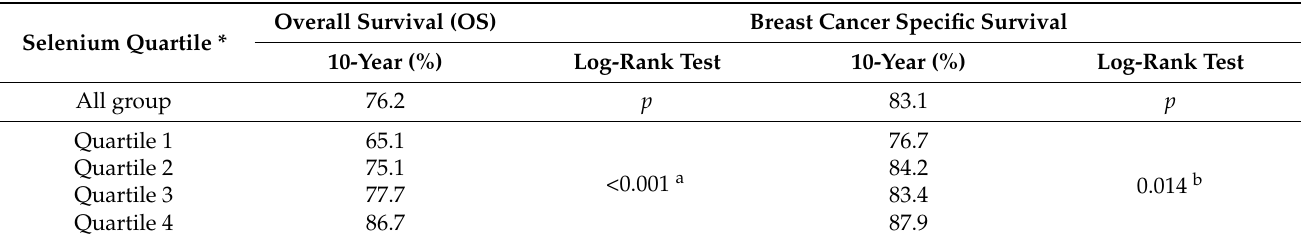
Table 2. 10-year overall and breast cancer specific survival.